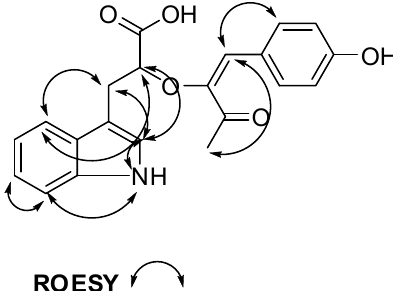
Figure 3. Key HMBC correlations (single arrows) show how the individual spin systems are connected through heteroatoms and quaternaries.